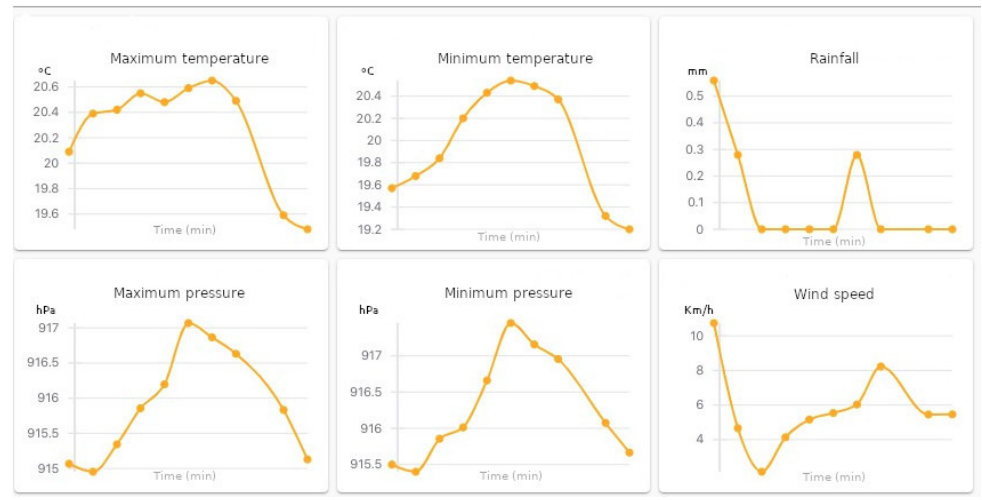
Figure 11. Reading of data via MQTT.